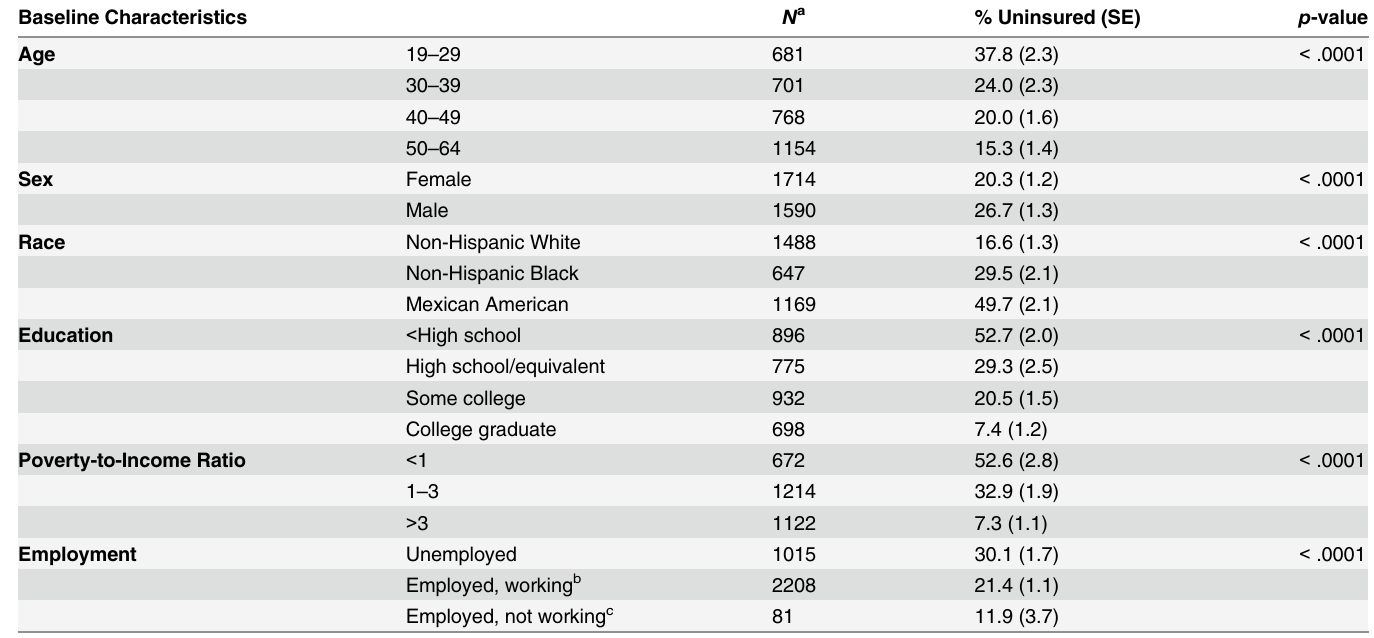
Table 1. Sample-weighted Baseline Characteristics of 2007 – 2010 NHANES Population (N = 3304) by Health Insurance